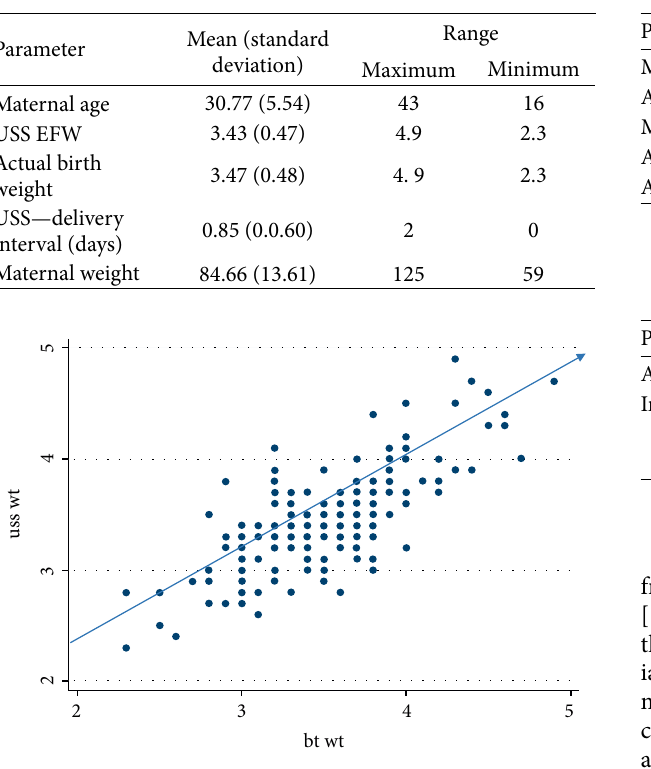
Figure 1: Correlation between the USS estimated weight and the actual birth weight. 𝑅 = 0.75 , 𝑝 -value = 0.04.